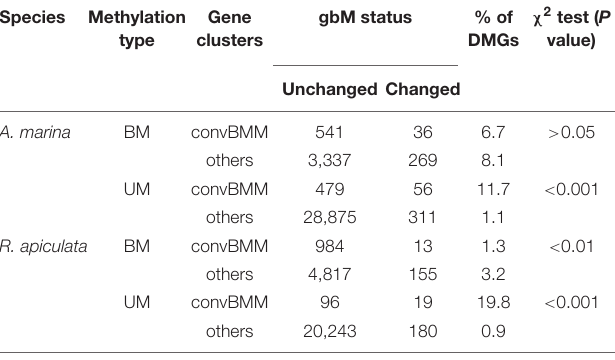
TABLE 1 | Salt-induced methylation changes in genes convergently gaining methylation in mangroves. Species Methylation